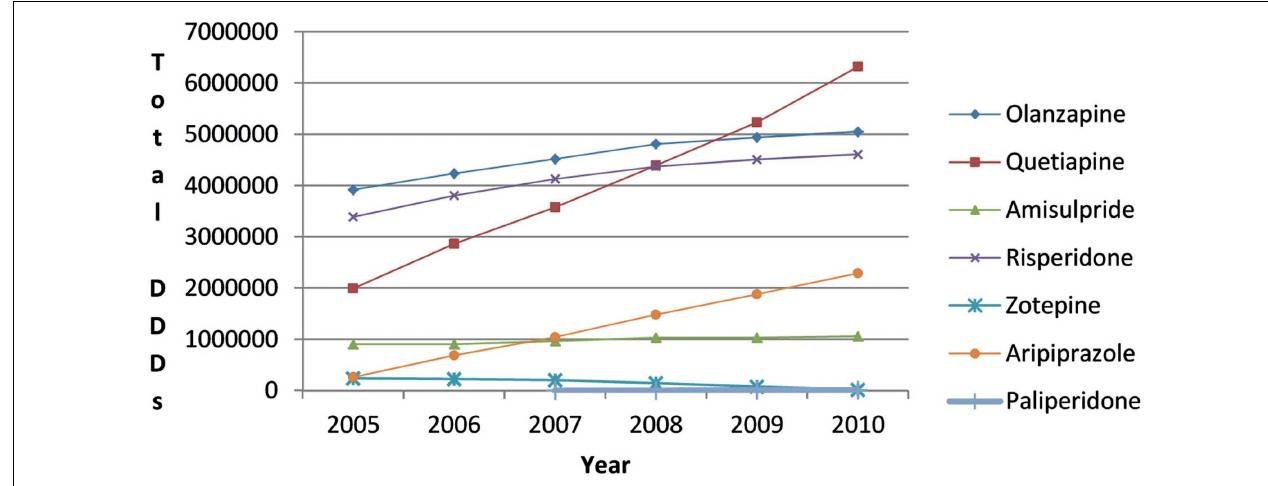
FIGURE 4 | Utilization of atypical antipsychotic drugs inAustria 2005–2010